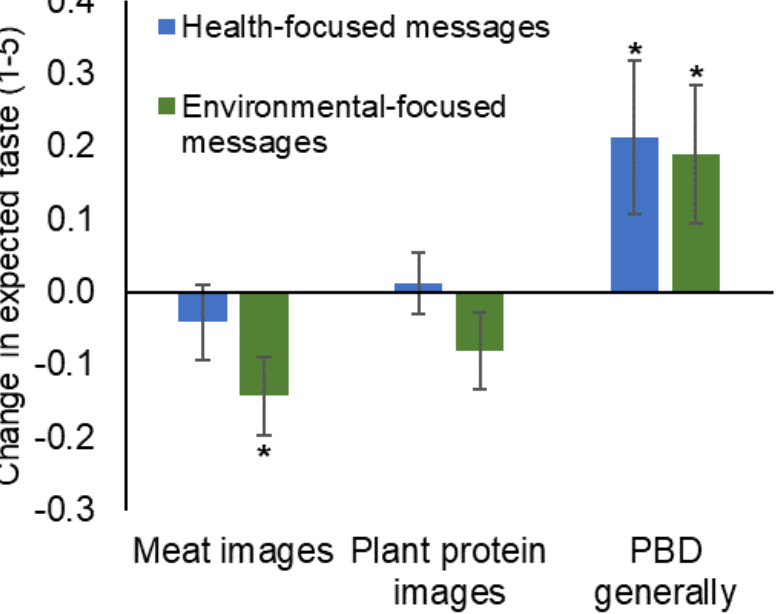
Figure 1. Impact of an eight-week text message intervention on expected taste, as measured by a five-point scale. Means and standard errors are represented. Asterisks indicate significant changes (postevaluation—pre-evaluation; p < 0.05).